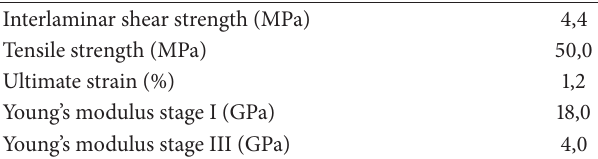
Table 1: Material characteristics of HPFRCC